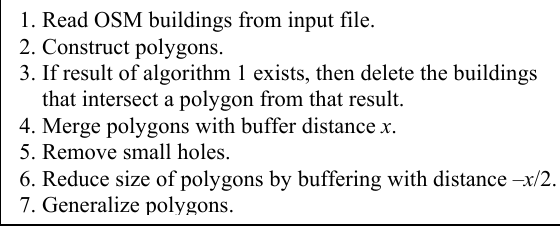
Figure 11. Algorithm 3 for processing OSM